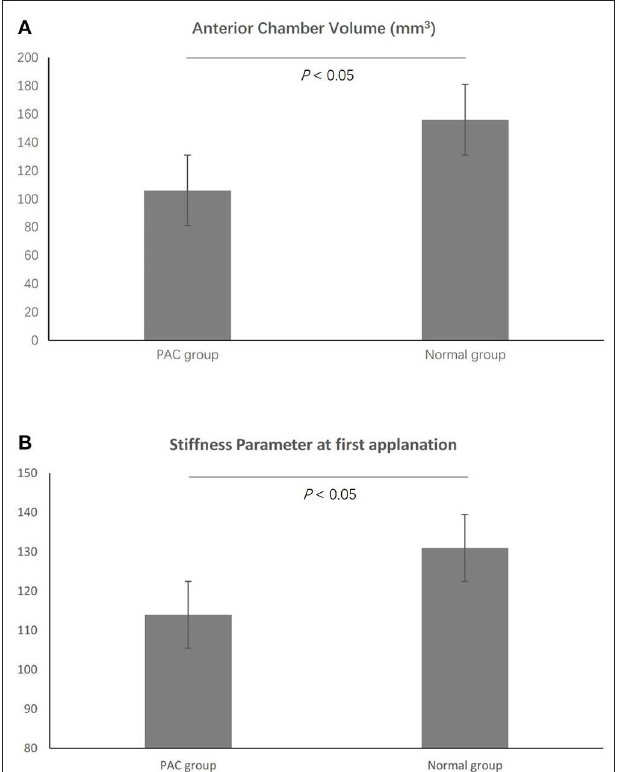
TABLE 4 | Factors associated with ACV based on multivariable linear regression model using backward selection. Variables Coefficient